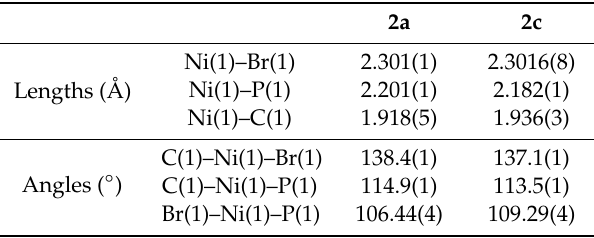
Table 1. Representative bond lengths and angles of 2a and 2c .